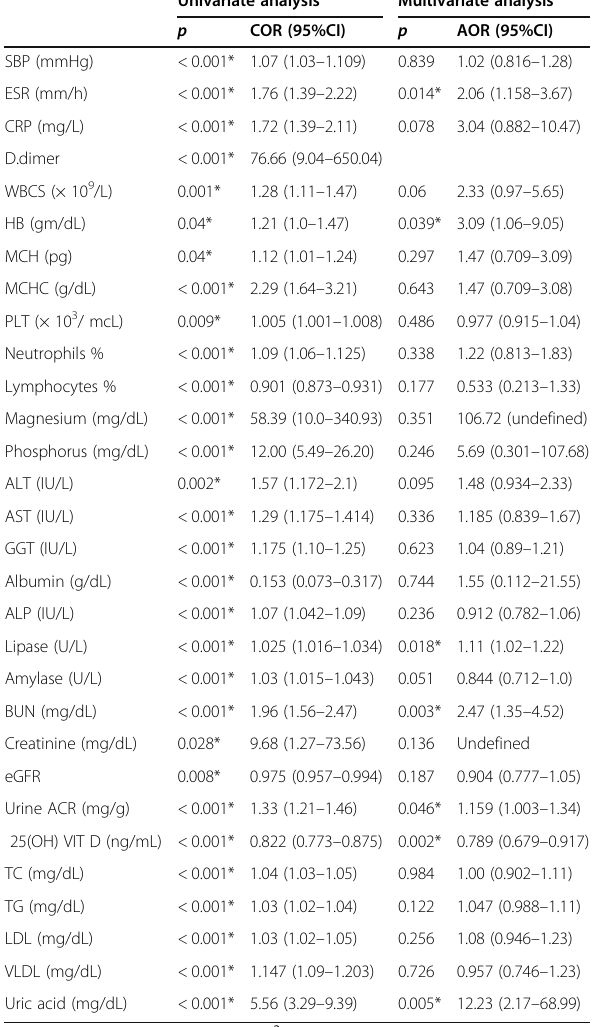
Table 4 Binary logistic regression in prediction of COVID-19